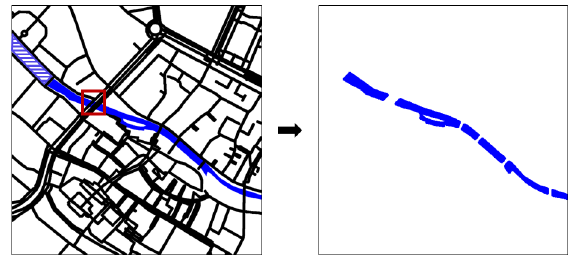
Figure 5. OSM mask preparation: overlaid OSM data (left), water mask W ¬ R